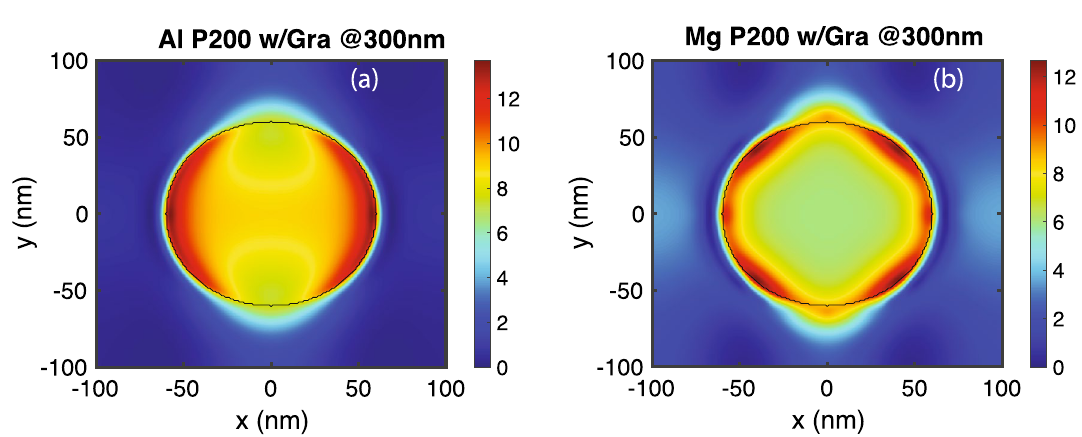
Figure 6. In-plane components of the electric field in graphene at the maximum absorption wavelength. ( a ) | E l | 2 in a monolayer of graphene on an aluminum hole-array with periodicity 200 nm at (cid:31) = 300 nm. ( b ) | E l | 2 in a monolayer of graphene on a magnesium hole-array with periodicity 200 nm at (cid:31) = 300